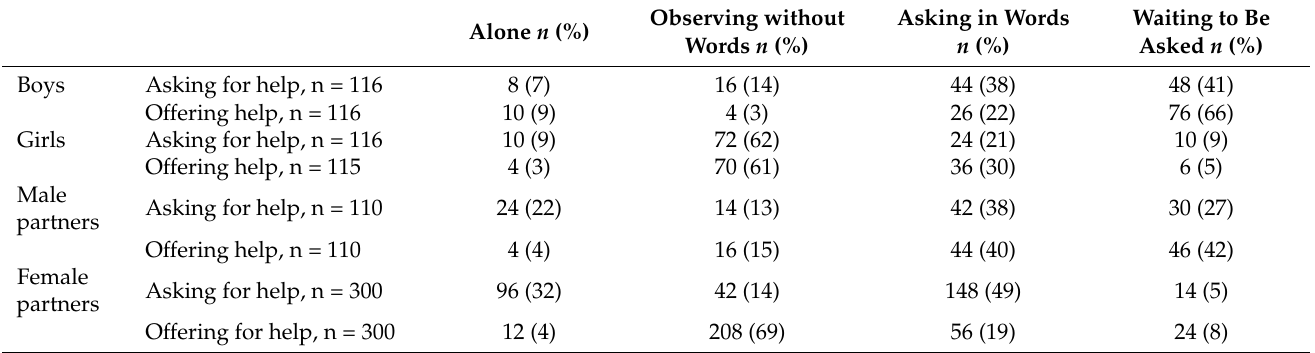
Table 1. Responses of boys, girls, male partners, and female partners in the following conditions: alone, observing without words, asking in words, or waiting to be